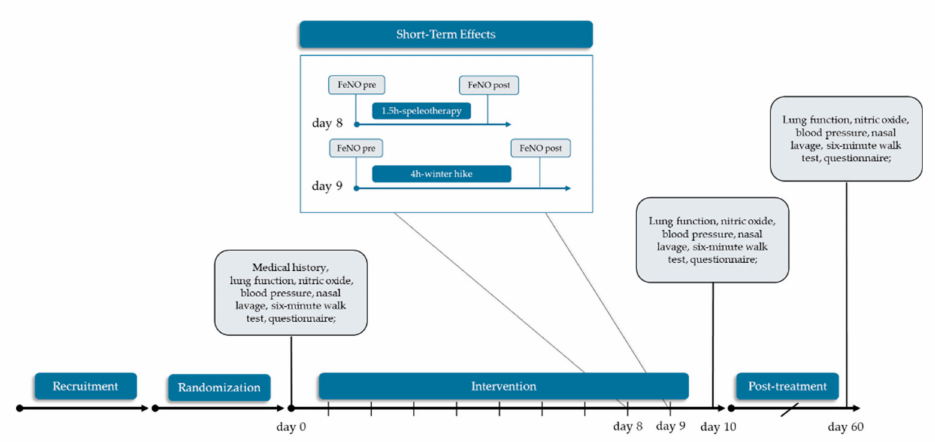
Figure 3. Study schedule. This work is focused on speleotherapy and winter exercise solely. No data from the control group are